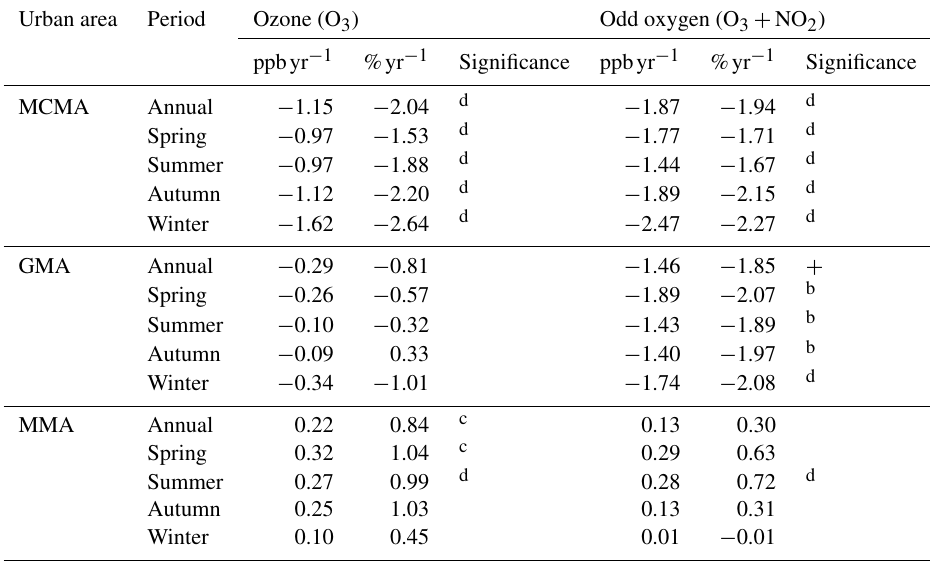
Table 4. Results for O 3 and O x long-term trends by season expressed in ppb yr − 1 during 1993–2014 for the MCMA and MMA and during 1996–2014 for the